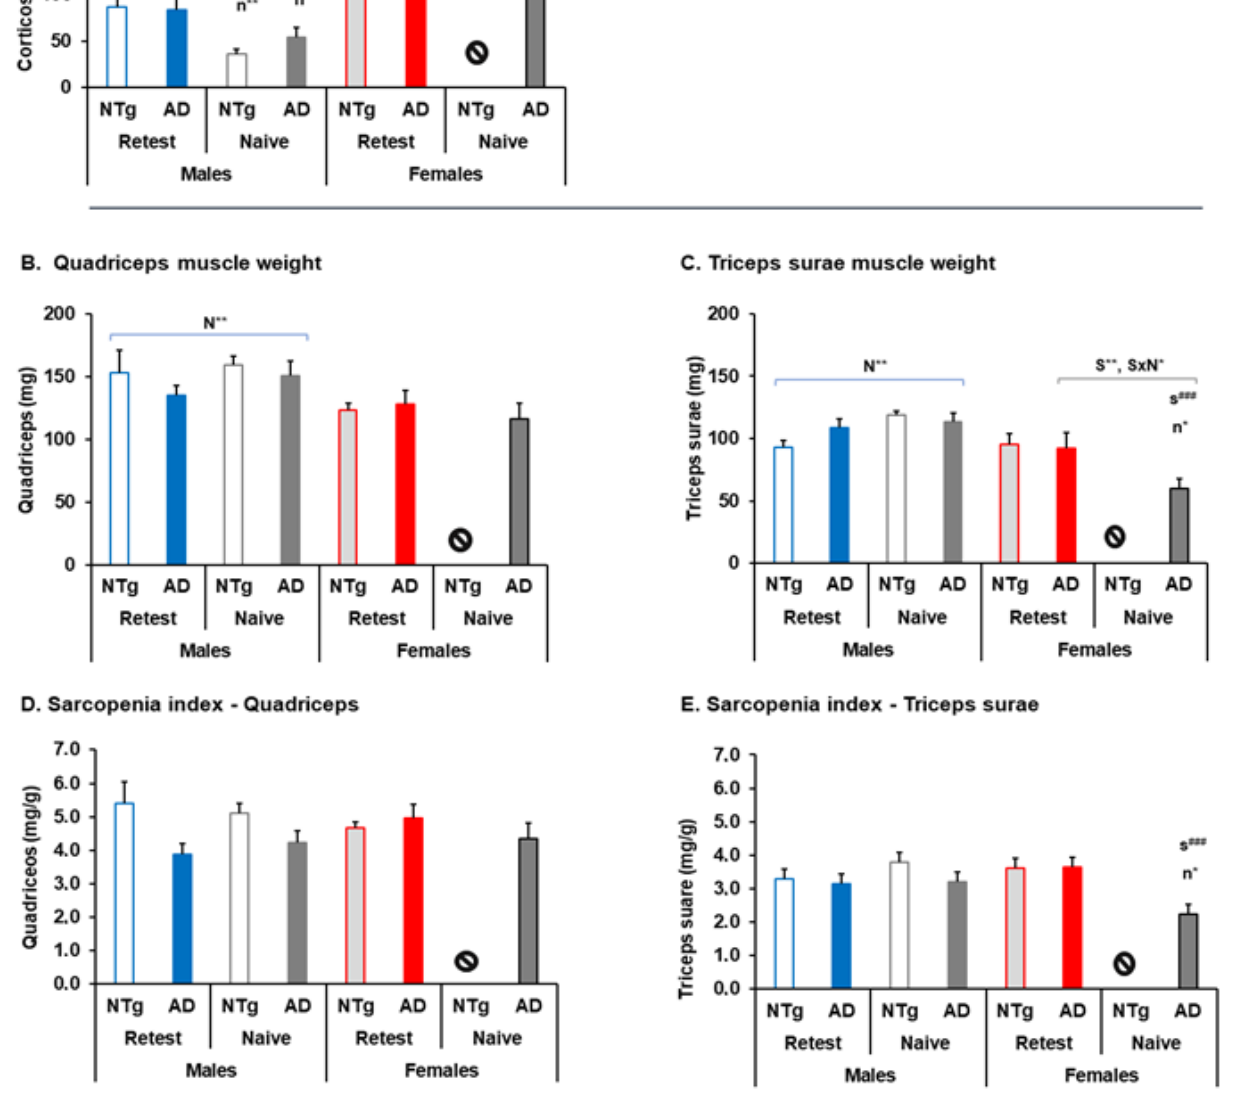
Figure 7. Biological status: HPA axis and sarcopenia index. ( A ) HPA axis, ( B ) quadriceps muscle weight, ( C ) triceps surae muscle, weight, ( D ) sarcopenia index — quadriceps, ( E ) sarcopenia index — triceps surae. Statistics: ANOVA, S, sex effect, S** p < 0.01**. N, naïve, naïve 16 months vs. re-test 16 months, N*** p < 0.001***, N** p < 0.01**. S×N, sex and naïve effects, S×N** p < 0.01**, S×N* p < 0.05*. Bonferroni post hoc test: s, sex; n: naïve, naïve 16 months vs. re-test 16 months; and # expressed sex differences between genotypes, s ### , p < 0.001 ### . The symbol ⦸ indicates the absence of the group, and m, months.